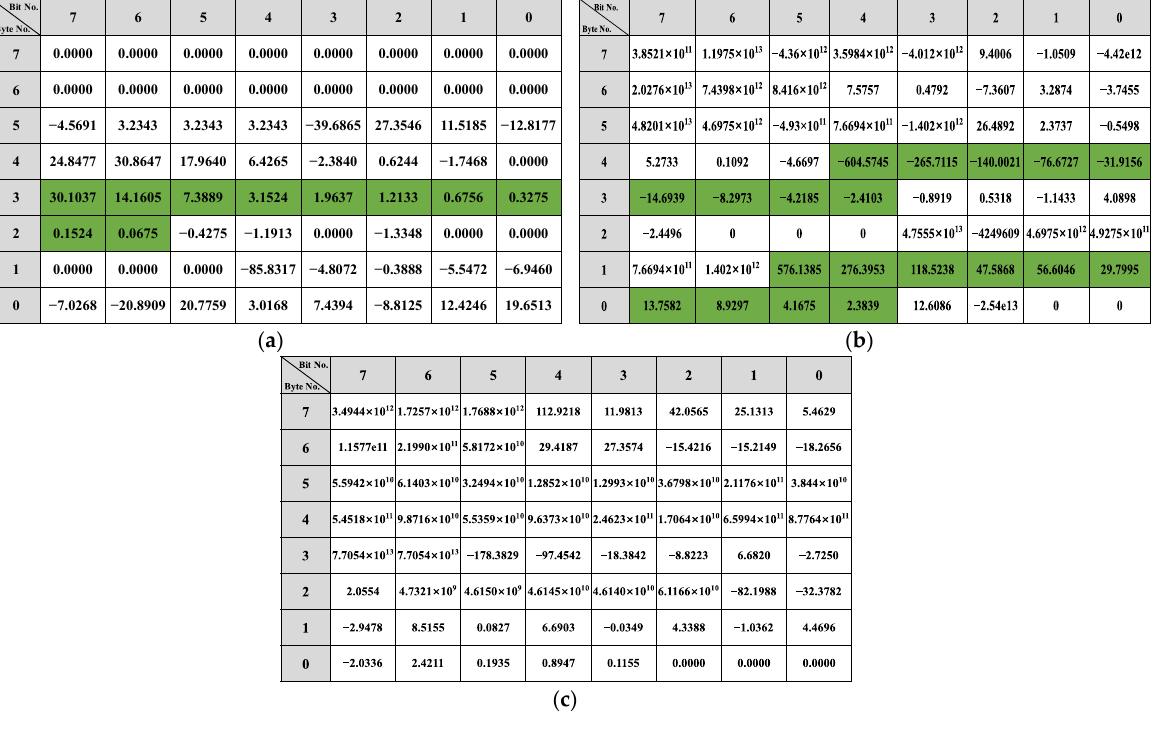
Figure 13. Steer-related messages reverse result: ( a ) ID 0x082 reverse result; ( b ) ID 0x086 reverse result; ( c ) ID 0x240 reverse result.